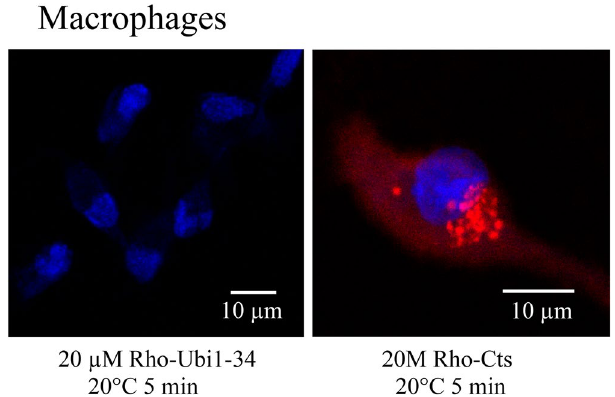
Figure 3. Confocal laser microscope observation of living macrophages incubated with rhodamine labeled peptides: 20 µM Rho-Ub1-34 and 20 µM Rho-Cts during 5 min at 20